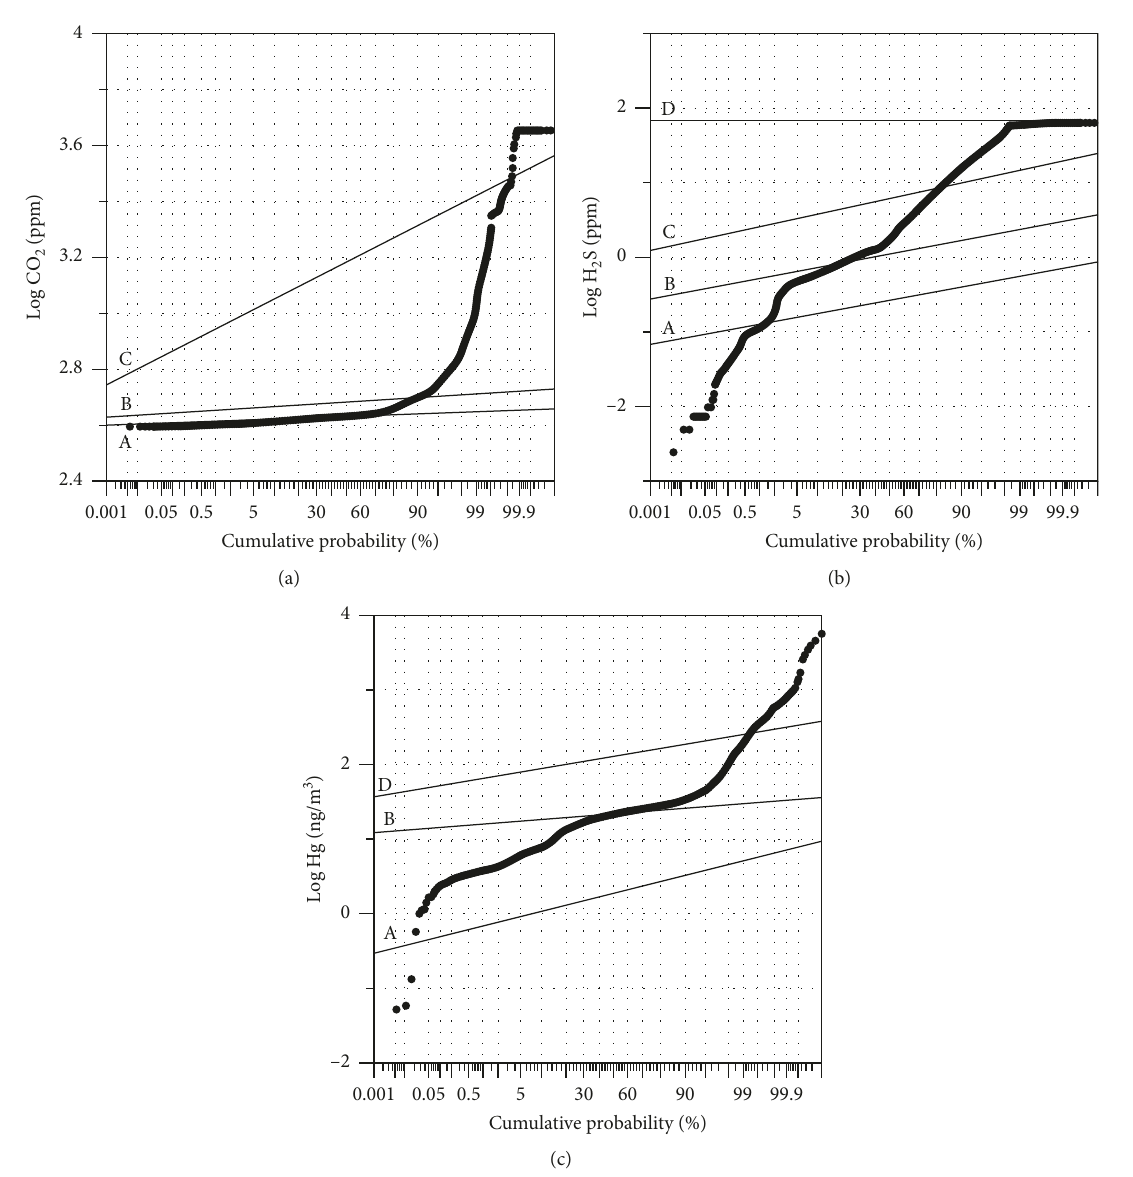
Figure 3: Probability plots of CO